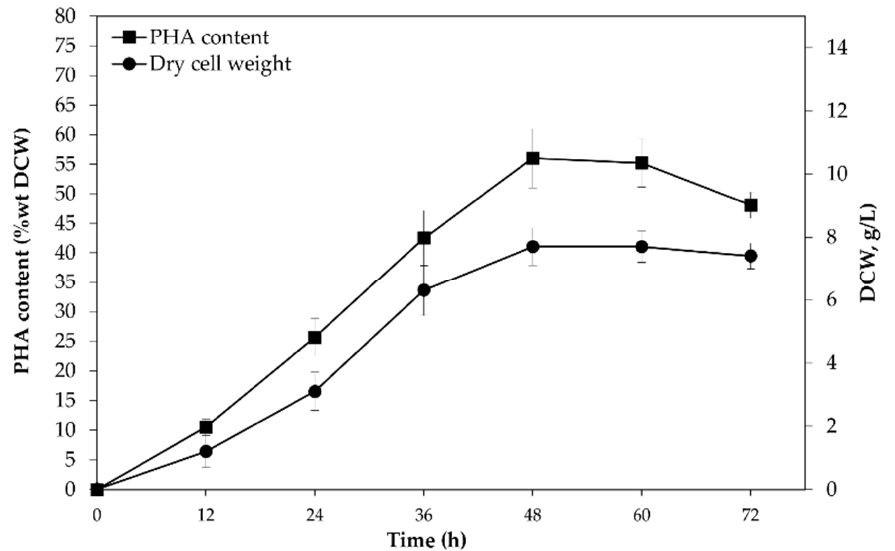
Figure 2. PHA production and biomass of C. necator PHB − 4/pBBR_CnPro- phaC Rp in 70 L stirred-tank bioreactor during 72 h.